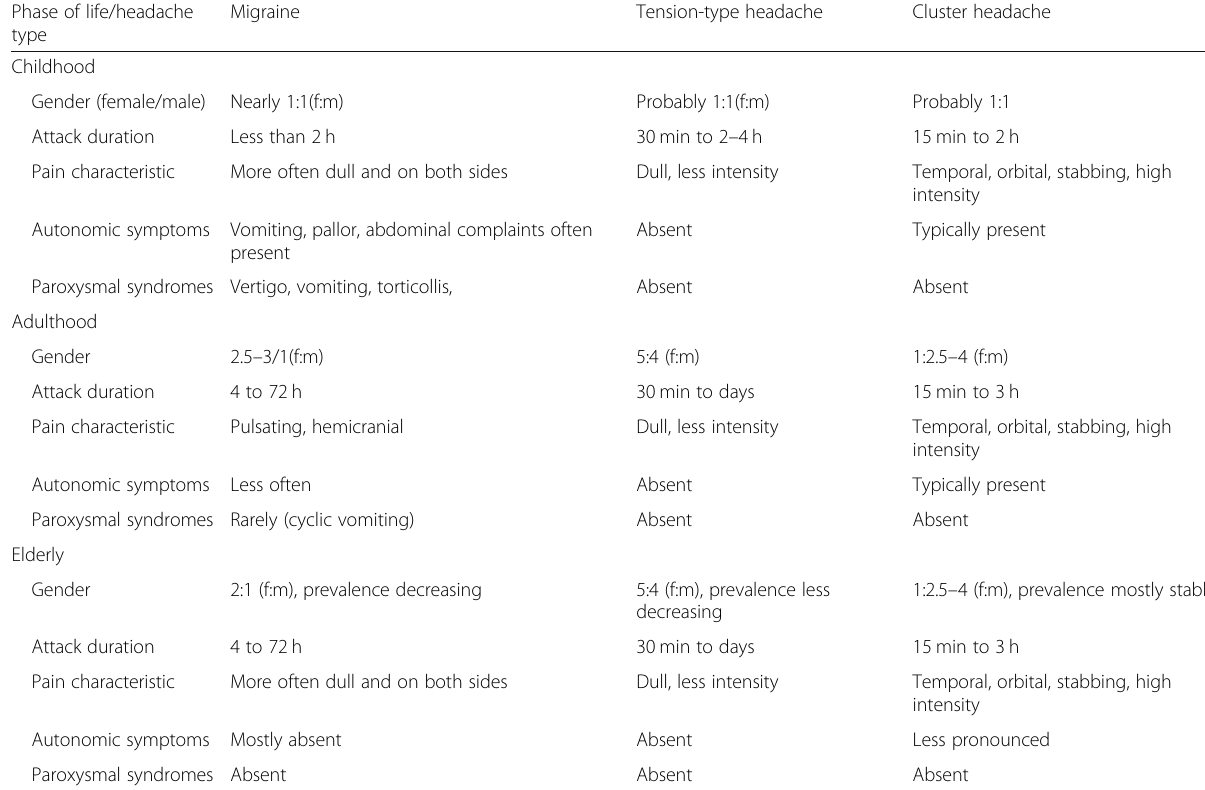
Table 2 Clinical differences in primary headaches during lifespan Phase of life/headache type